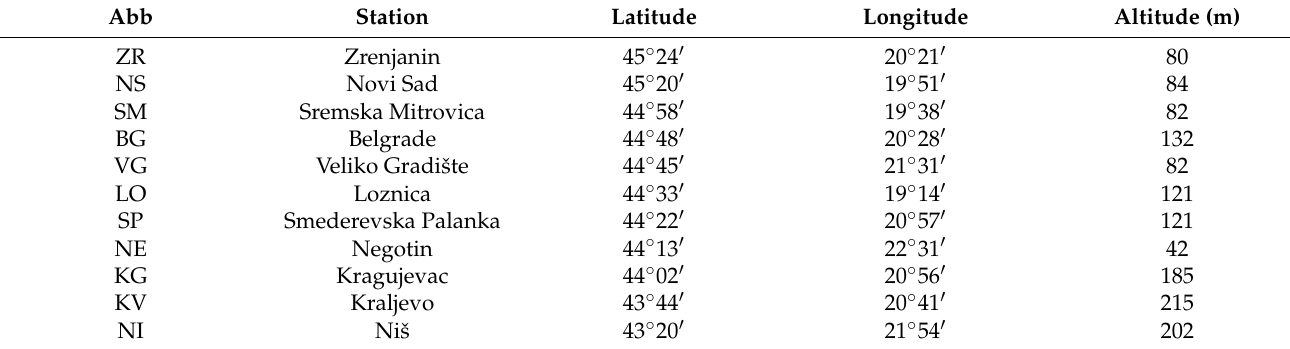
Table 1. Abbreviation (Abb) of meteorological stations with their latitude, longitude and altitude (m).